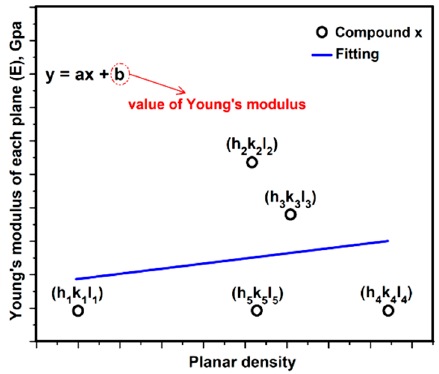
Figure 3. Young’s modulus extracted from planes of compound x versus planar density.